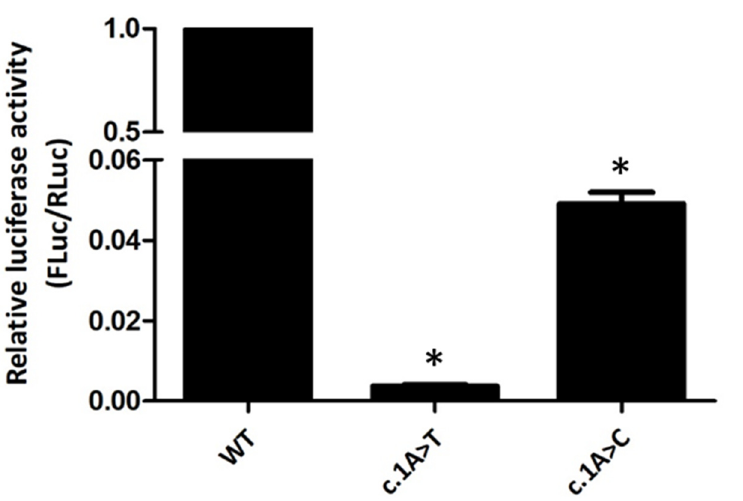
Figure 2. Relative luciferase activity of LDLR_pGL4 constructs with c.1A>T, p.(Met1Leu) or c.1A>C, p.(Met1Leu) variants. CHO-ldlA7 cells were transiently co-transfected with each one of the LDLR_pGL4 constructs (containing Firefly Luciferase—FLuc) and with the pRL-TK plasmid encod- ing the Renilla Luciferase (RLuc). Cells were lysed 24 h later, and the luciferase activity was meas- ured by luminometry assays. FLuc activity values were normalized to RLuc activity to control for transfection efficiency. Relative luciferase activity of the LDLR_pGL4-WT (WT) construct was de- fined as one. All values represent the mean of triplicate independent determinations ( n = 3); error bars represent ± SD. * p < 0.001 compared to LDLR WT using a two-tailed Student’s t -test.